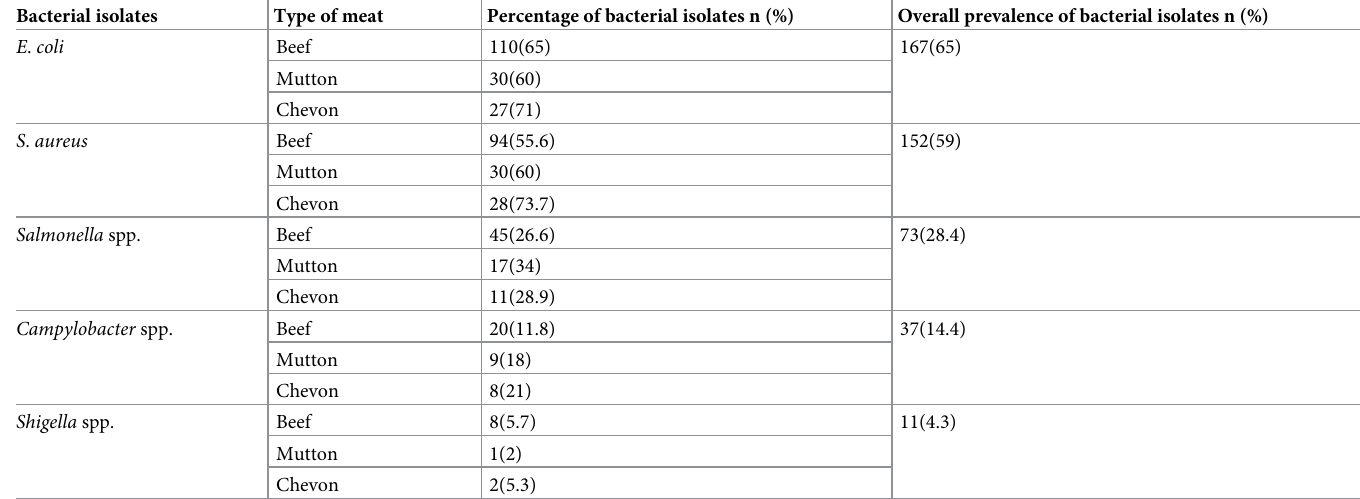
Table 3. Bacterial isolates from different RTE raw minced meats served in hotels and restaurants of Arba Minch town from 01 July to 31 December, 2020. Bacterial isolates